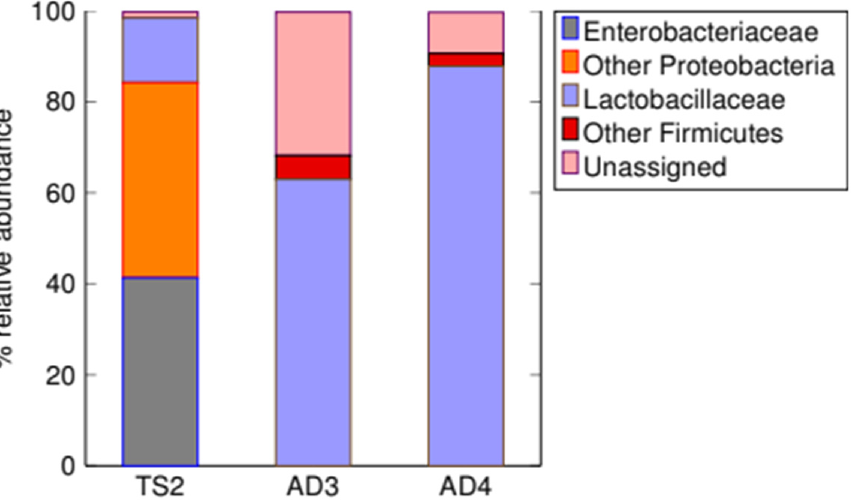
of 16S rRNA sequences deposited in SILVA [38] (Table 4).